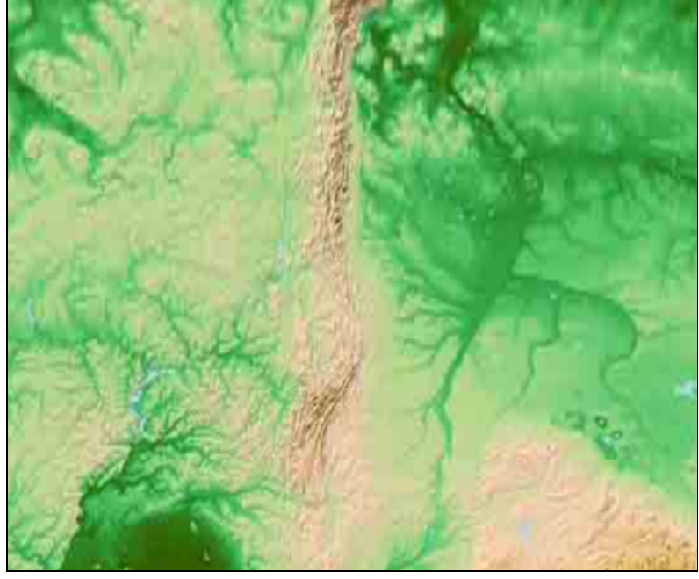
Figure 14. The hypsometric map of the